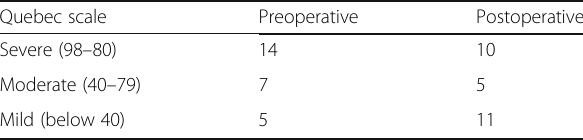
Table 1 Assessment of pain on daily activities using the Quebec scale among our patients Quebec